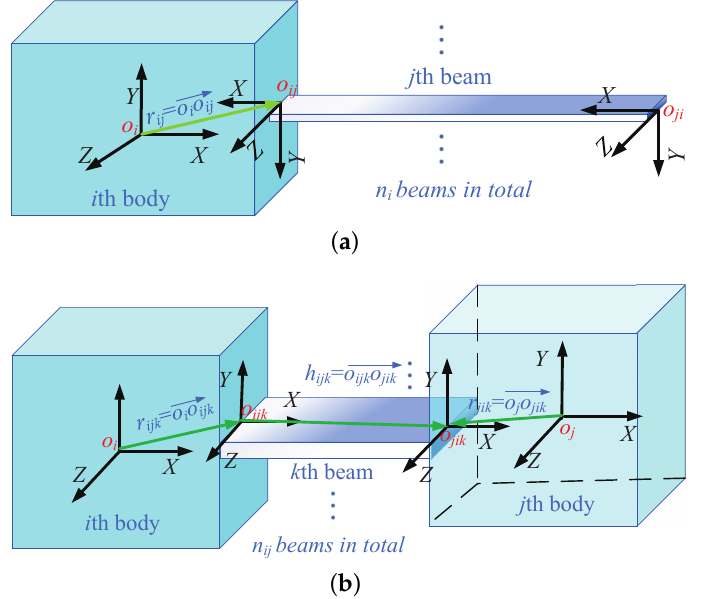
Figure 2. ( a ) The i th rigid body connected with the j th flexure beam. ( b ) The i th rigid body and the j th rigid body are connected by the k th flexure